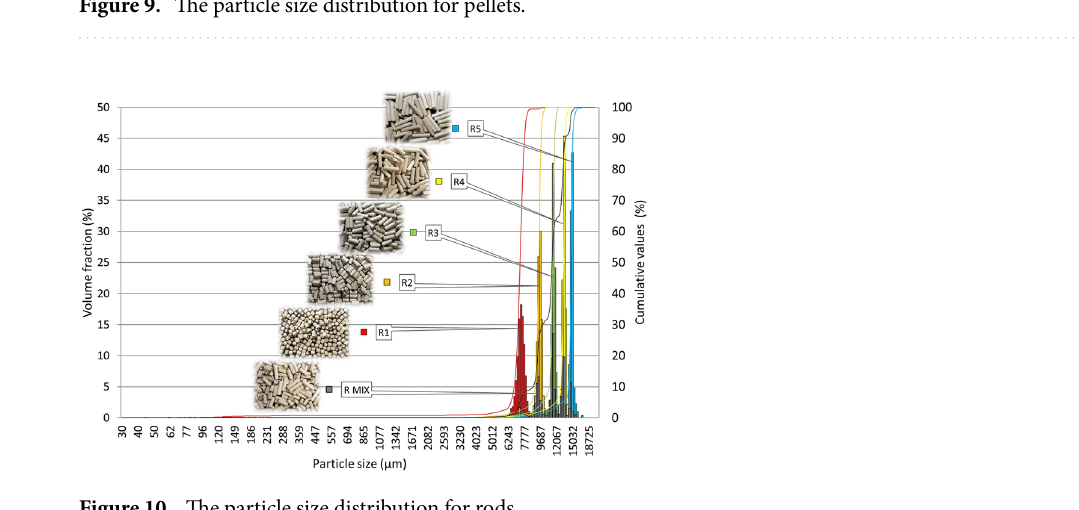
Figure 9. The particle size distribution for pellets.